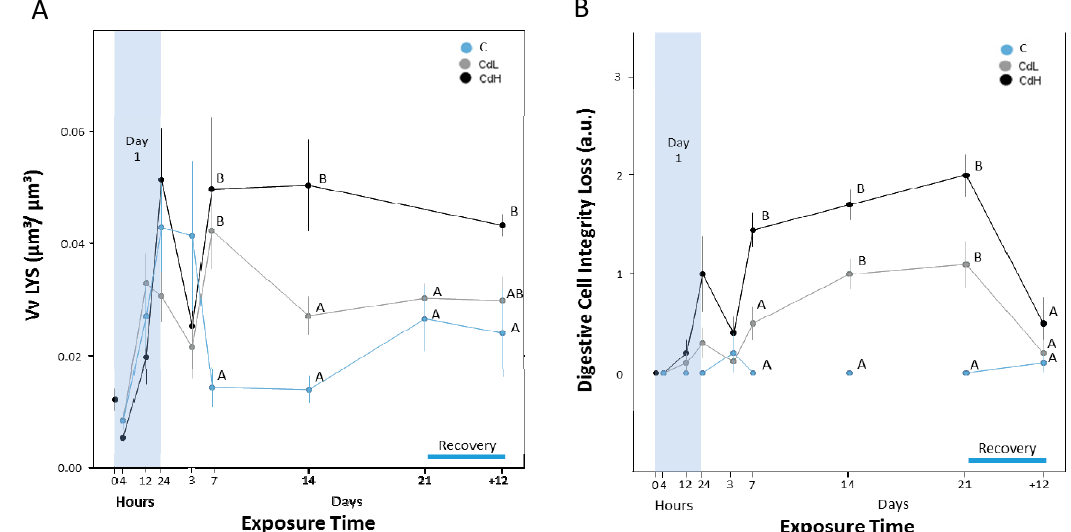
Figure 5. ( A ) Progression of volume density of lysosomes (Vv LYS ) in the digestive cells of midgut gland tubules of Littorina littorea . Means (symbols) and standard errors (bars) are shown. Different letter codes between single values of the same time point indicate statistically significant differences ( p < 0.05); ( B ) Course of integrity loss of digestive cells (DCI) in the midgut gland tubular epithelium, expressed in arbitrary units (a.u.) (see Table 1 in the Materials and Methods section for explanation). Means (symbols) and standard errors (bars) are shown. Different letter codes between single values of the same time point indicate statistically significant differences ( p < 0.05).